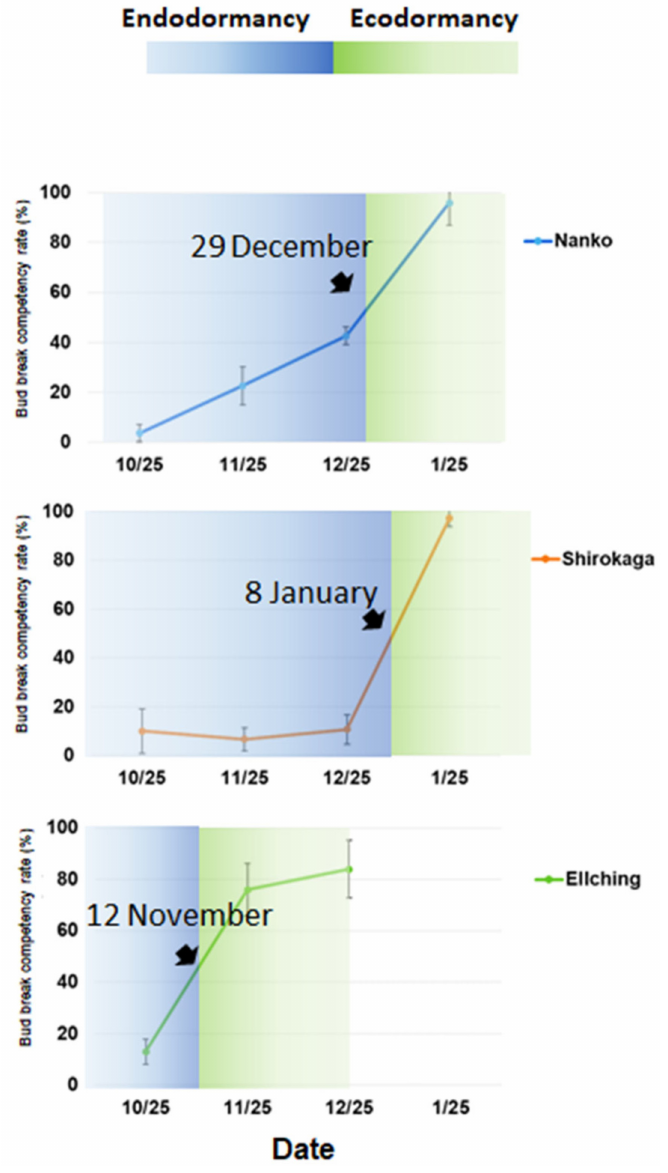
Figure 2. Seasonal changes in the bud break competency of the floral buds of three cultivars. The CR fulfillment dates were estimated to be 29 December, 8 January, and 12 November for the late-blooming ‘Nanko’, the extra-late-blooming ‘Shirokaga’, and the early-blooming ‘Ellching’, respectively. Five replicates were analyzed, and 15 nodes were examined for each replicate. The error bars represent the